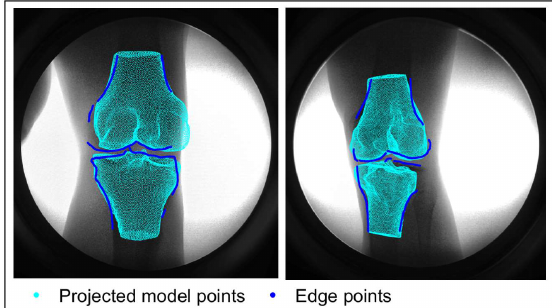
Figure 8. A failed registration for both of the tibia and the femur due to the initial pose being outside of the capture range of the